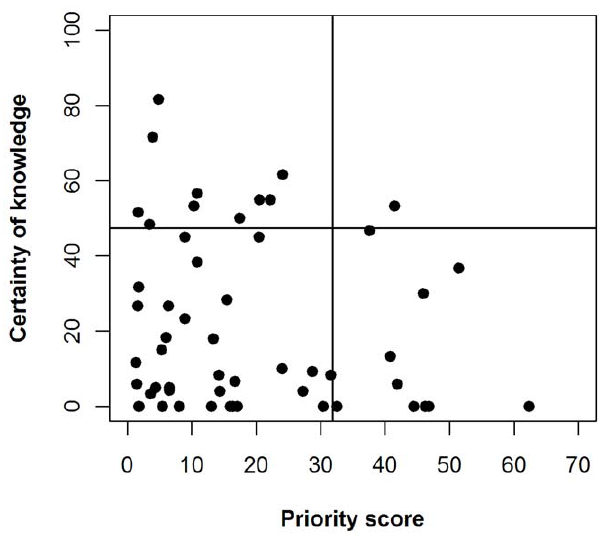
Figure 5. A method for setting research priorities. Each intervention to conserve wild bees is plotted according to its mean certainty of knowledge score (assessed by three experts) and mean priority score (assessed by 44 practitioners). The ten interventions in the ‘research priority’ quadrant of high priority but low certainty of knowledge (bottom right) are listed in table S2. Lines are drawn at the 80% quantiles for knowledge and priority scores.